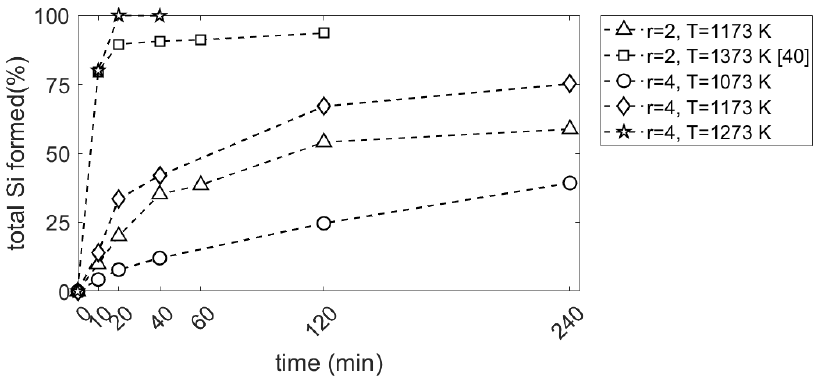
Figure 6. Total Si formed against reaction time (r is the Mg/SiO 2 mole